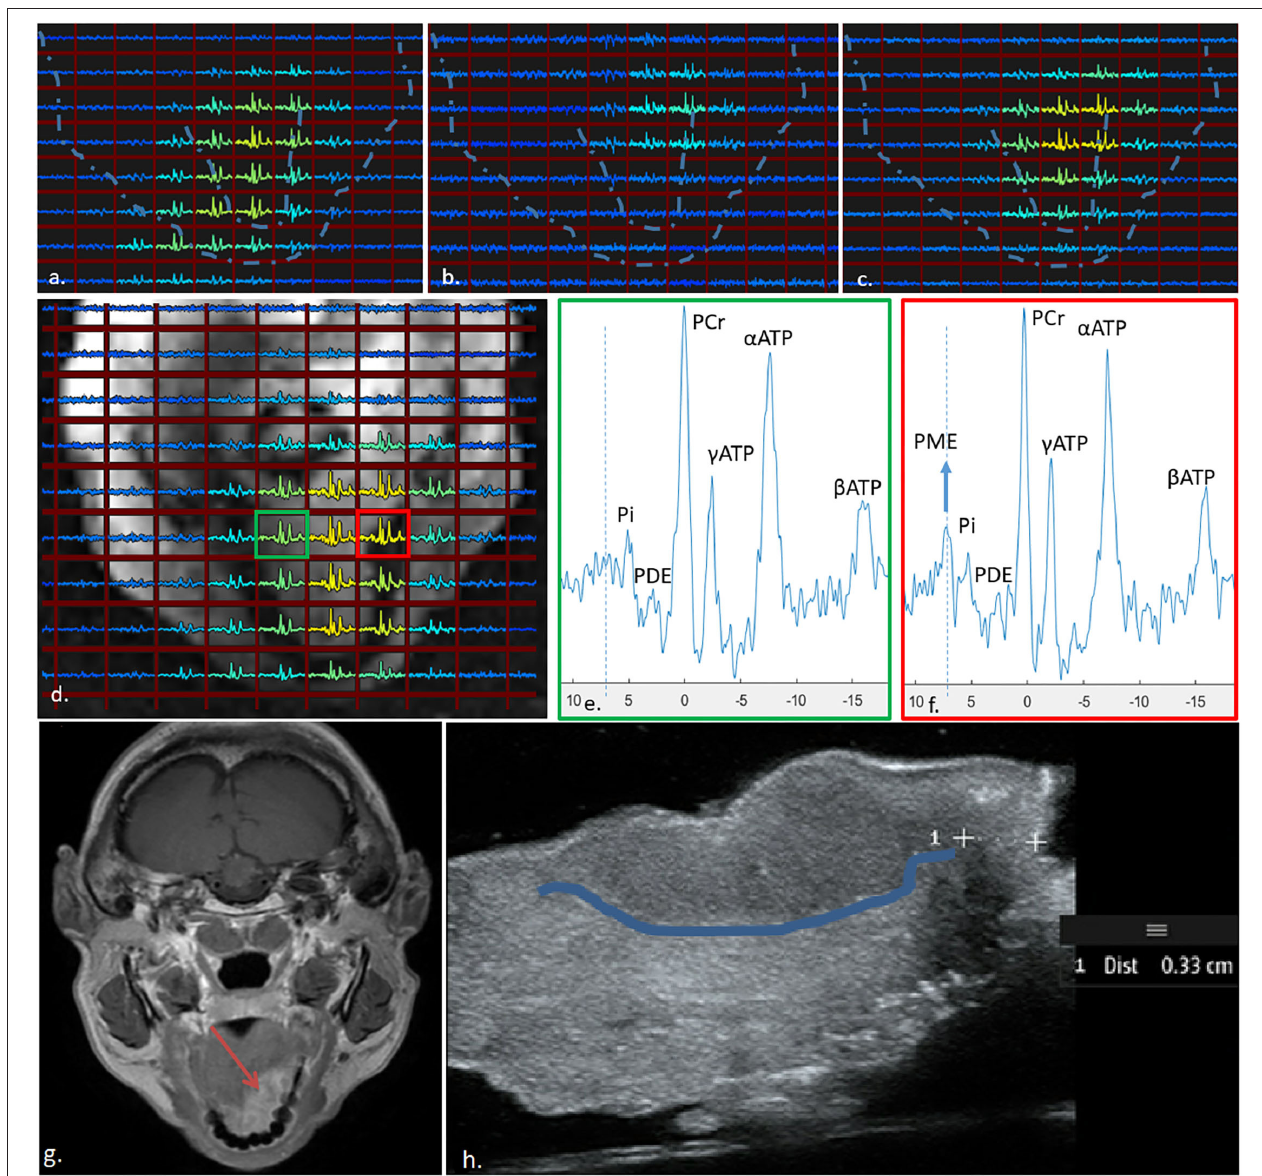
FIGURE 4 | 31 P MRSI results obtained from the tongue of a patient with a tumour (indicated by the red square in (d) using the three-channel external receiver array. The signal contributions from the centre, left, and right coil are indicated in (a–c) , respectively, and averaged using WSVD in (d) . The spectrum from the tumour (f) shows much higher signal of PME as compared to the spectrum obtained contralateral in the tongue (e) . Dotted lines in (a–c) , show outline of face and tongue as in (d) . (g) shows a clinical 3-T image and (h) is the resection specimen (post-surgery) with the tumour boundary highlighted.